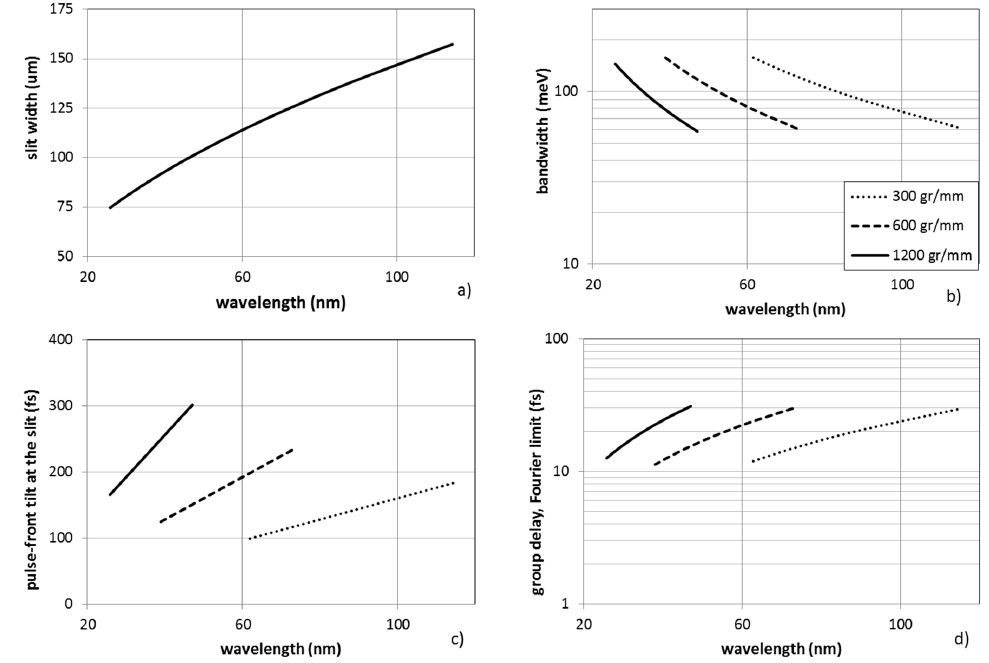
Table 1. Requirements and parameters for a TDC monochromator with sub-150 meV energy